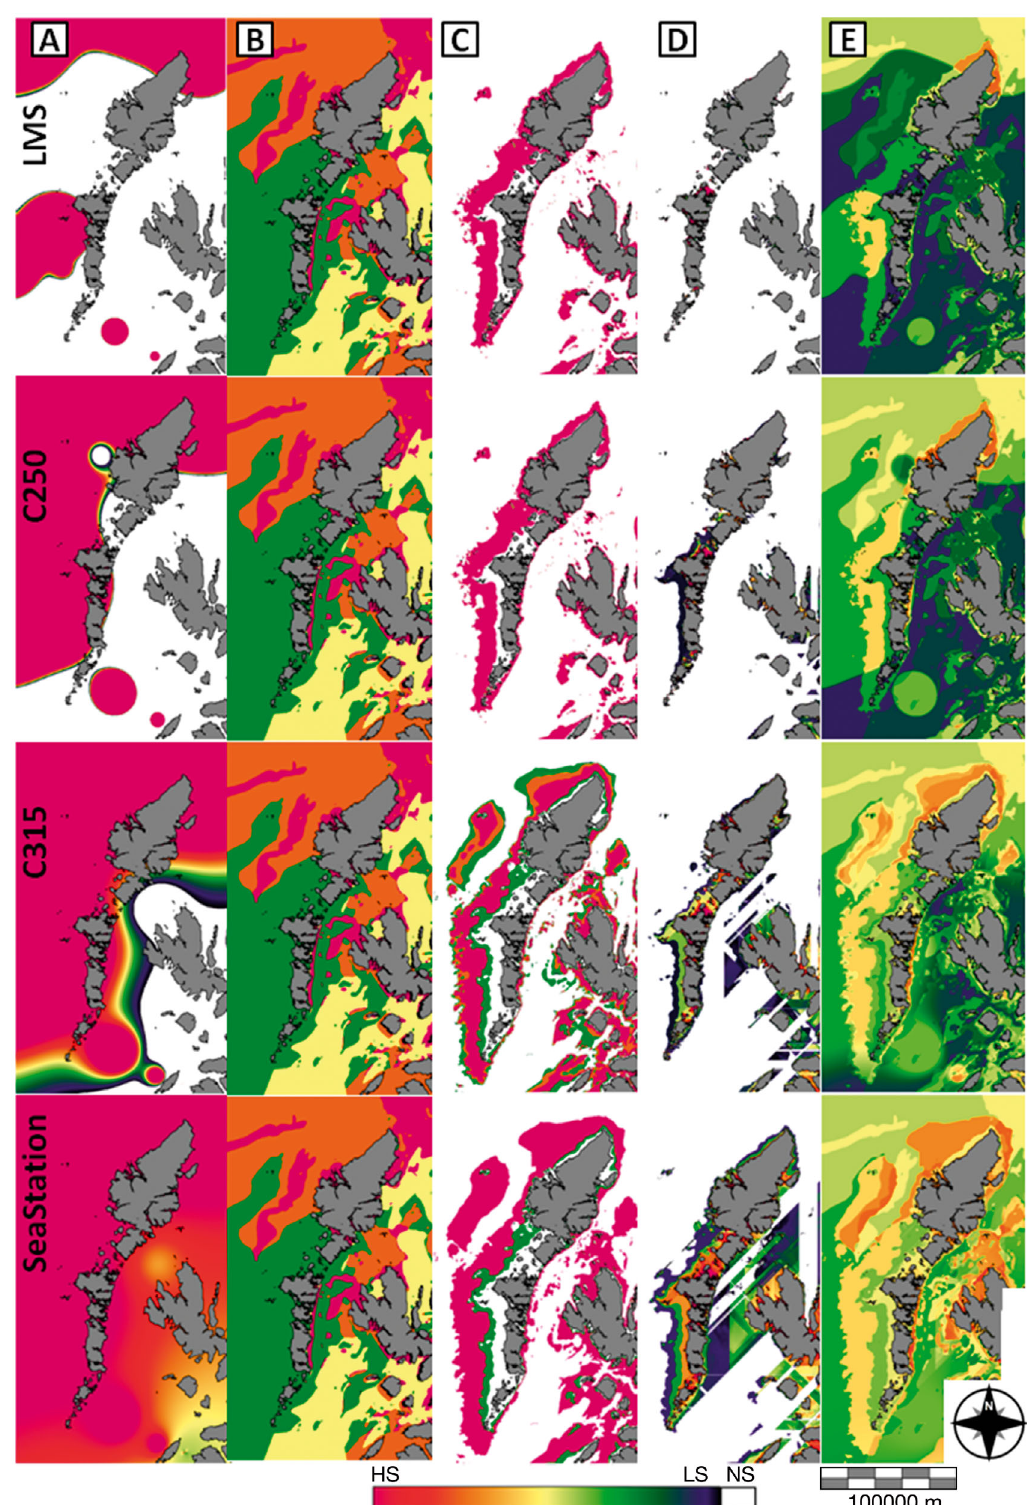
Fig. 4. Individual fuzzy classification submodels and overall fuzzy submodel. Suitability for marine cage fish farming is as- sessed on a continuous scale: NS, not suitable; LS, low suitability; HS, high suitability. (A) Maximum current velocity, (B) sub- strate type, (C) depth, (D) significant wave height, (E) overall fuzzy model. Cage types: LMS, C250, C315,